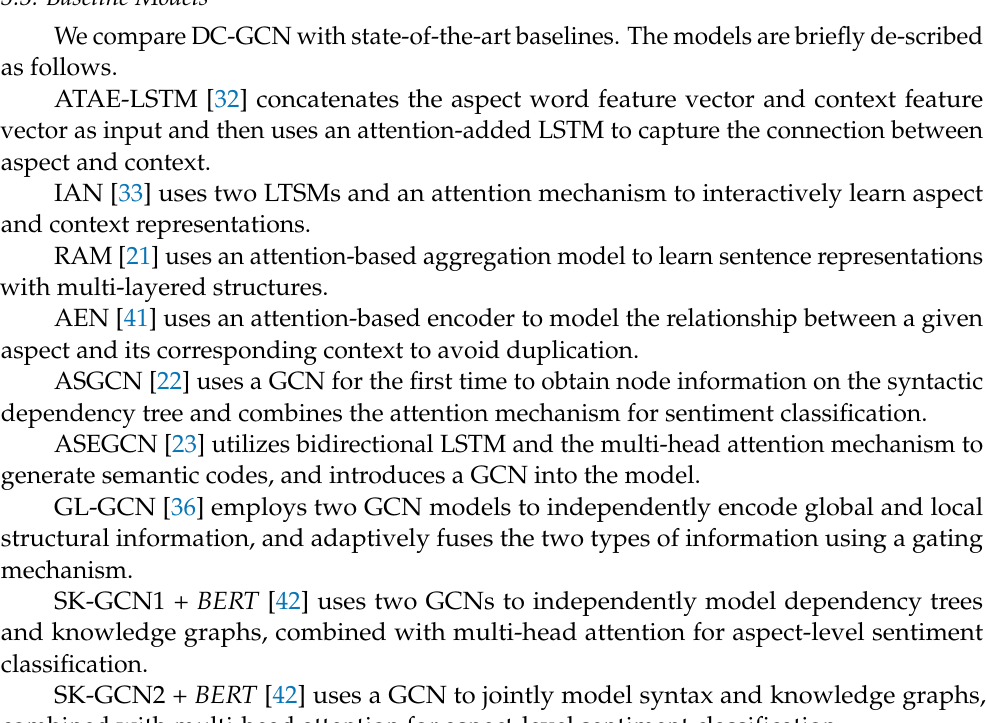
Table 2. Hyper-parameter settings. Parameters Values Word embedding dimensions 768 GCN layers 32 Dropout rate 0.3 Learning